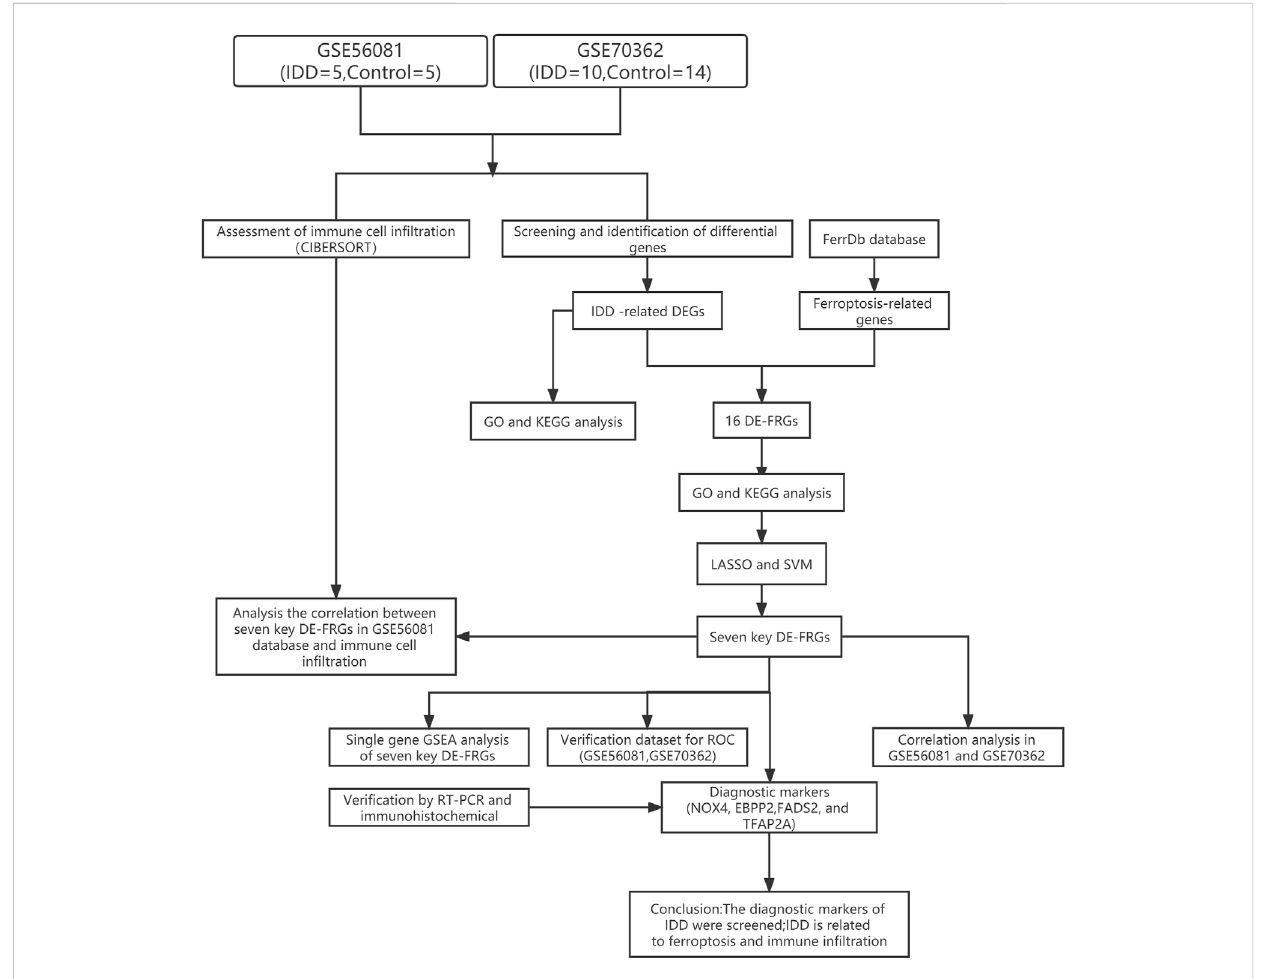
FIGURE 1 The fl owchart of the analysis process.